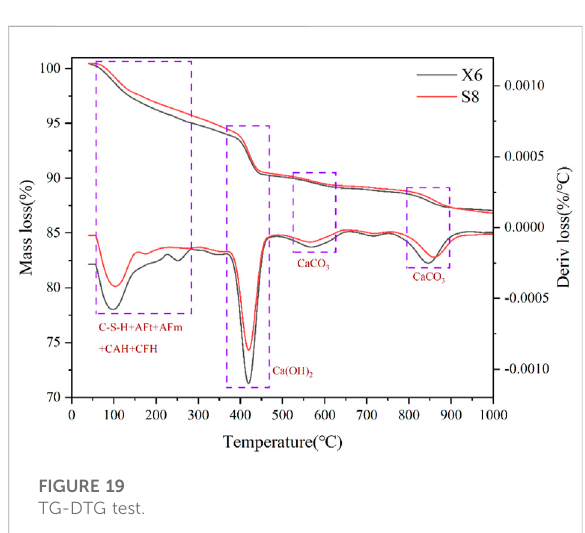
FIGURE 19 TG-DTG